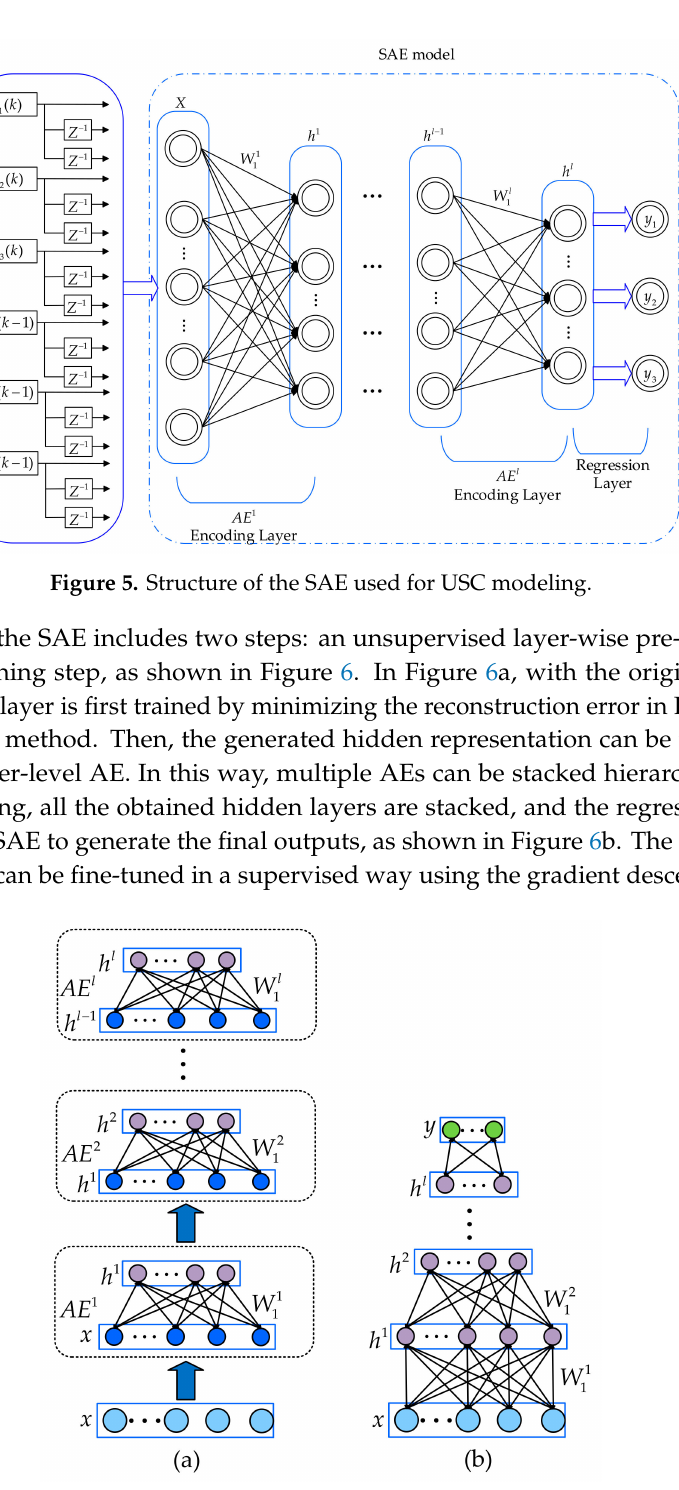
Figure 6. ( a ) Unsupervised layer-wise pre-training of the SAE. ( b ) Supervised fine-tuning of the